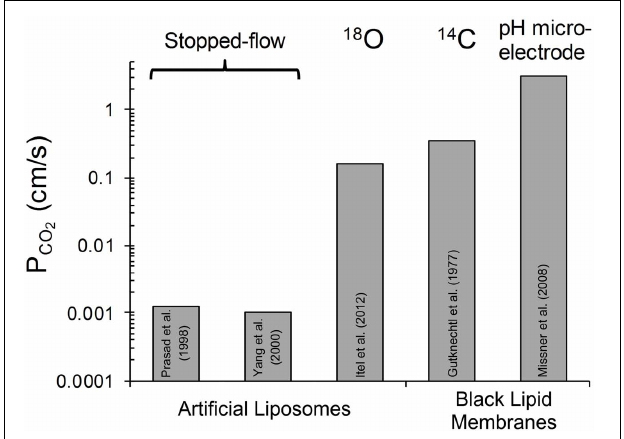
FIGURE 1 | Overview of CO 2 permeabilities determined for artificial liposomes or planar lipid bilayers using various techniques.